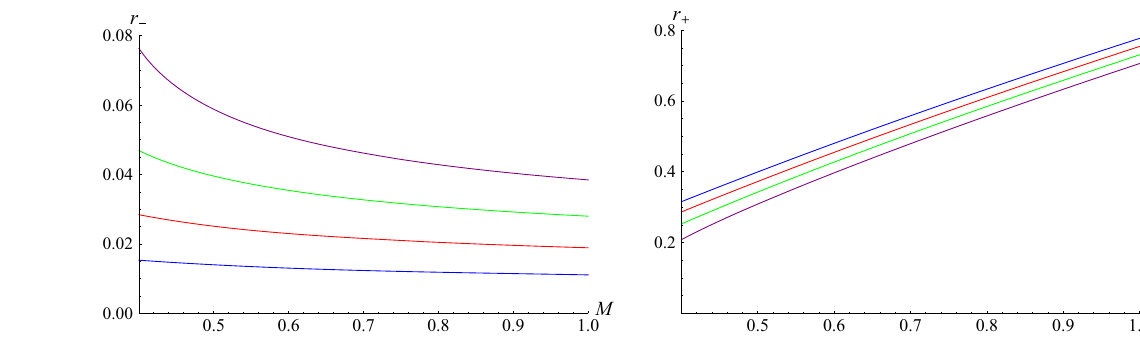
Fig. 4 We plot the inner horizon radius (left) and the event horizon radius (right) in terms of the black hole mass, for the different values of the characteristic parameter k of the non-linear electrodynamics, at